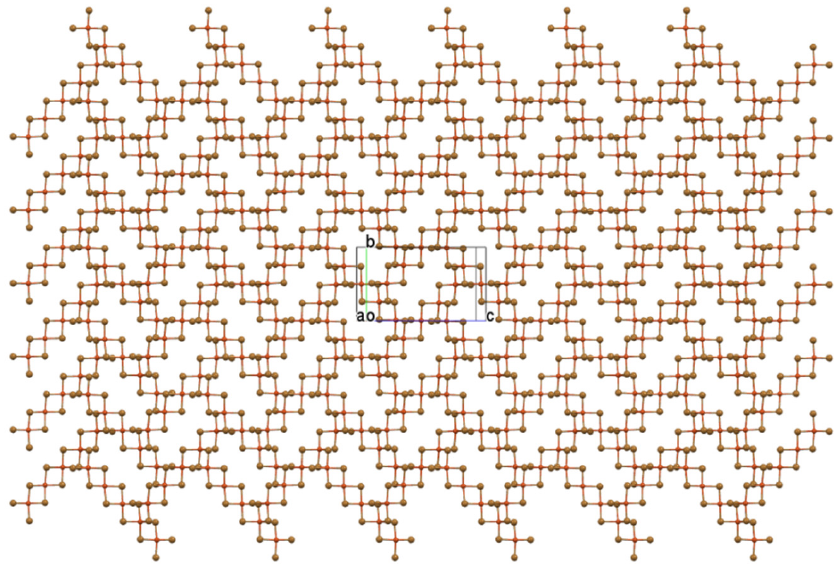
Figure 3. Ball-and-stick plot of the cross-hatched, pentanuclear oligomer layer viewed perpendicular to (100) with b vertical and c horizontal.